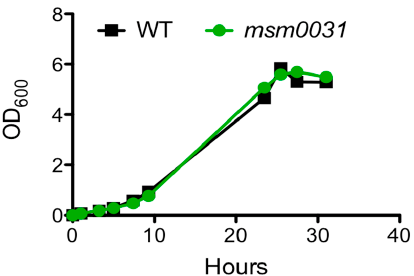
Figure 2. Growth of the msm0031::Tn mutant and wild-type (WT) M. smegmatis cells in batch culture.